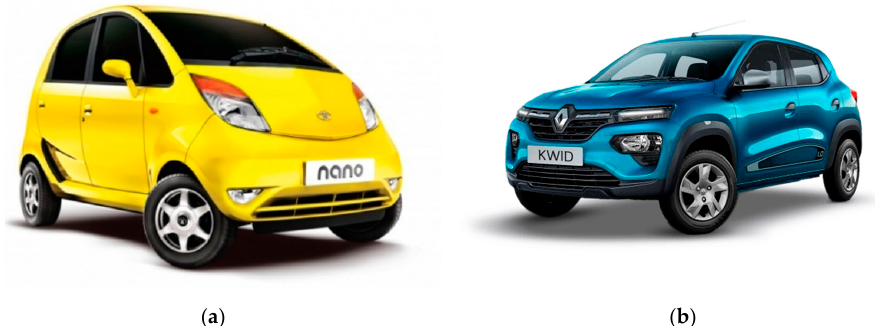
Figure 5. Passenger car case study: ( a ) Tata Nano; ( b ) Renault Kwid.